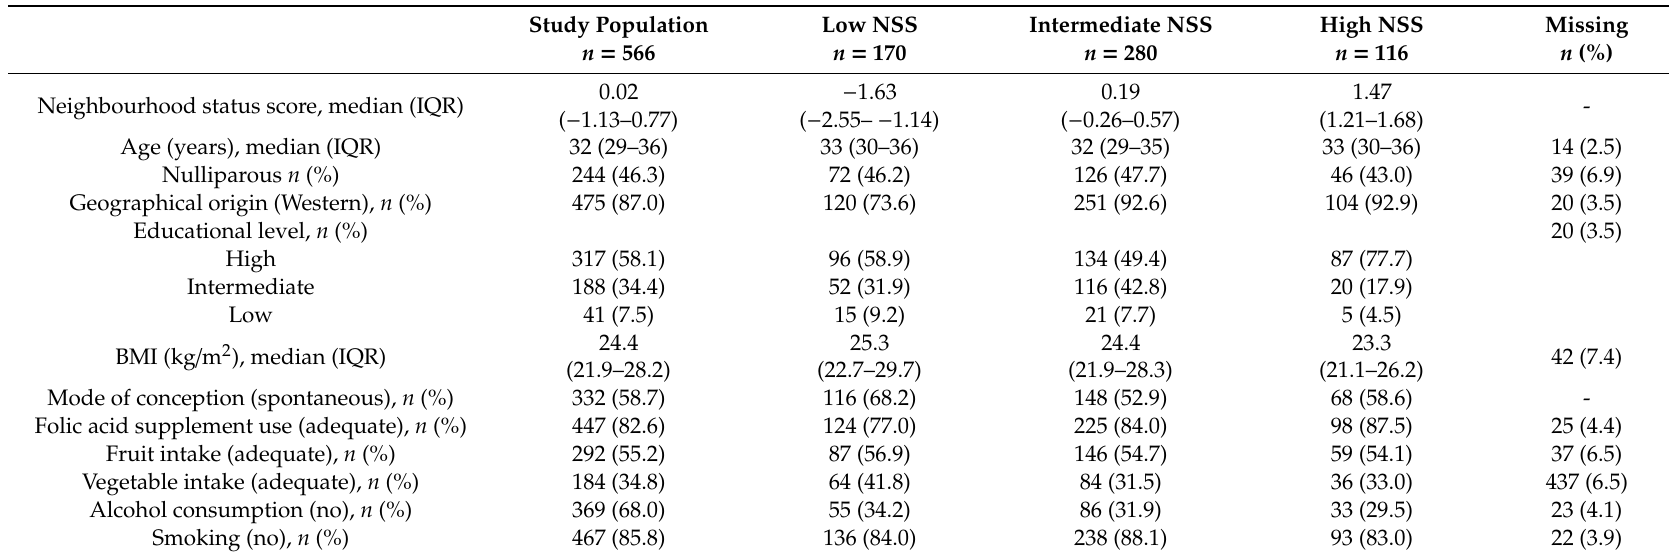
Table 1. Maternal baseline characteristics and nutrition and lifestyle behaviours of the total study population and stratified for neighbourhood status score (NSS)